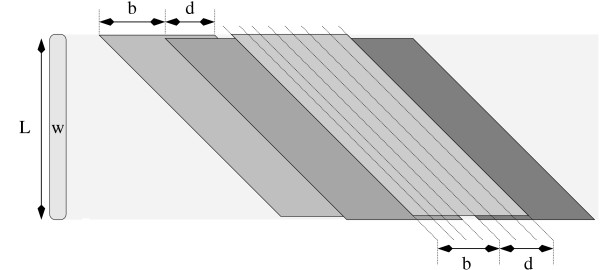
Enlarging parallelograms from d + 1 to d + b diagonals. Four parallelograms with b + d diagonals, starting in diagonals kb, for any integer k. Example with d = 3, b = 4. Notice that two consecutive enlarged parallelograms of this form share d common diagonals and that any parallelogram with d + 1 diagonals is contained in one such enlarged parallelogram with b + d diagonals.